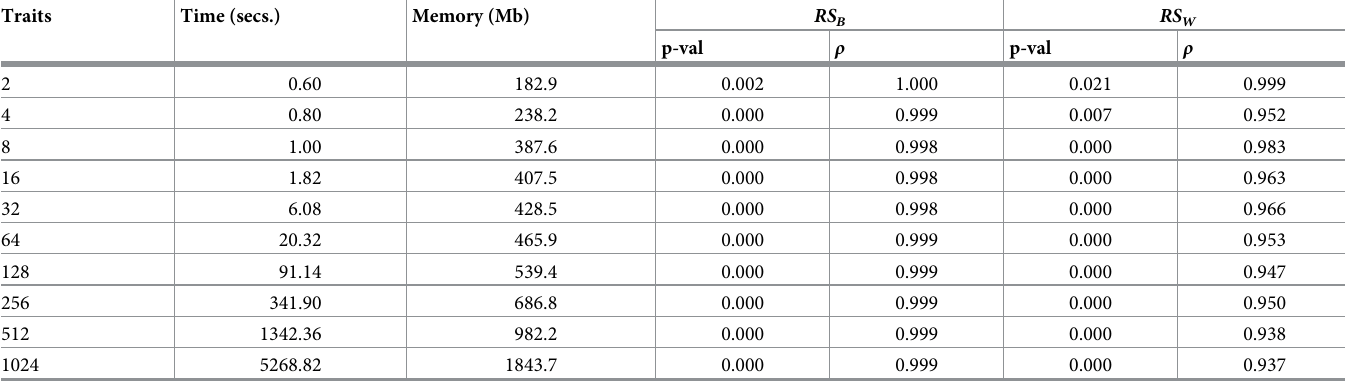
Table 1. Accuracy and feasibility of the pooled-within covariance estimation. Memory (Mb), time (sec) and accuracy (random skewer correlation) of the pooled-within covariance estimation approach. RS B corresponds to the random skewer test for the phylogenetic covariance and RS W to the dynamic component. Traits Time